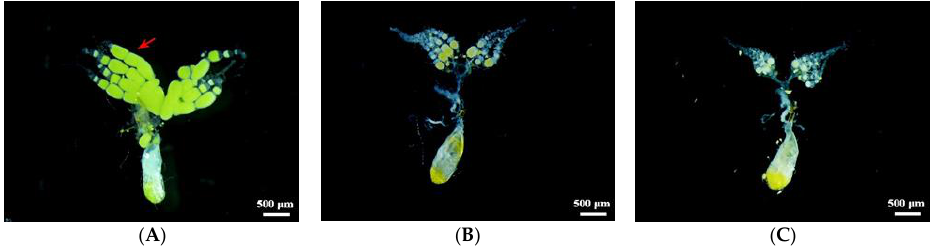
Figure 4. Effects of ds ISWI and ds BRM on Tuta absoluta ovary development. ( A ) Ovaries of unin- jected 4 d females. ( B ) Abnormal ovaries of 4 d females injected with ds ISWI . ( C ) Abnormal ovaries of 4 d females injected with ds BRM. The red arrow represents the mature oocytes. The ovaries were photographed under an Olympus stereomicroscope (SZX16; Olympus, Tokyo, Japan). See more pictures in Figure S5.